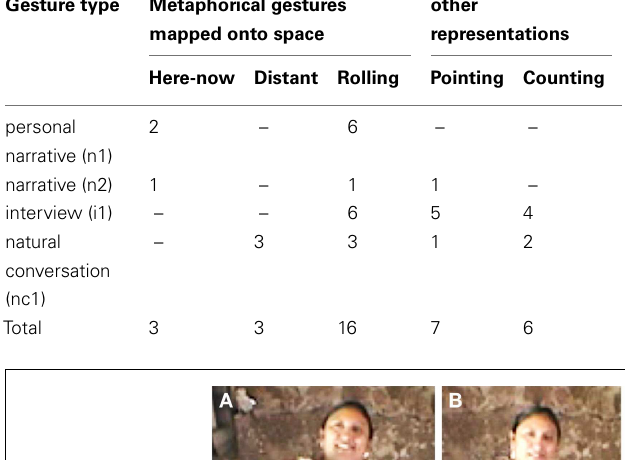
Table 4 | Gesture types occurring with time adverbs and time reference.